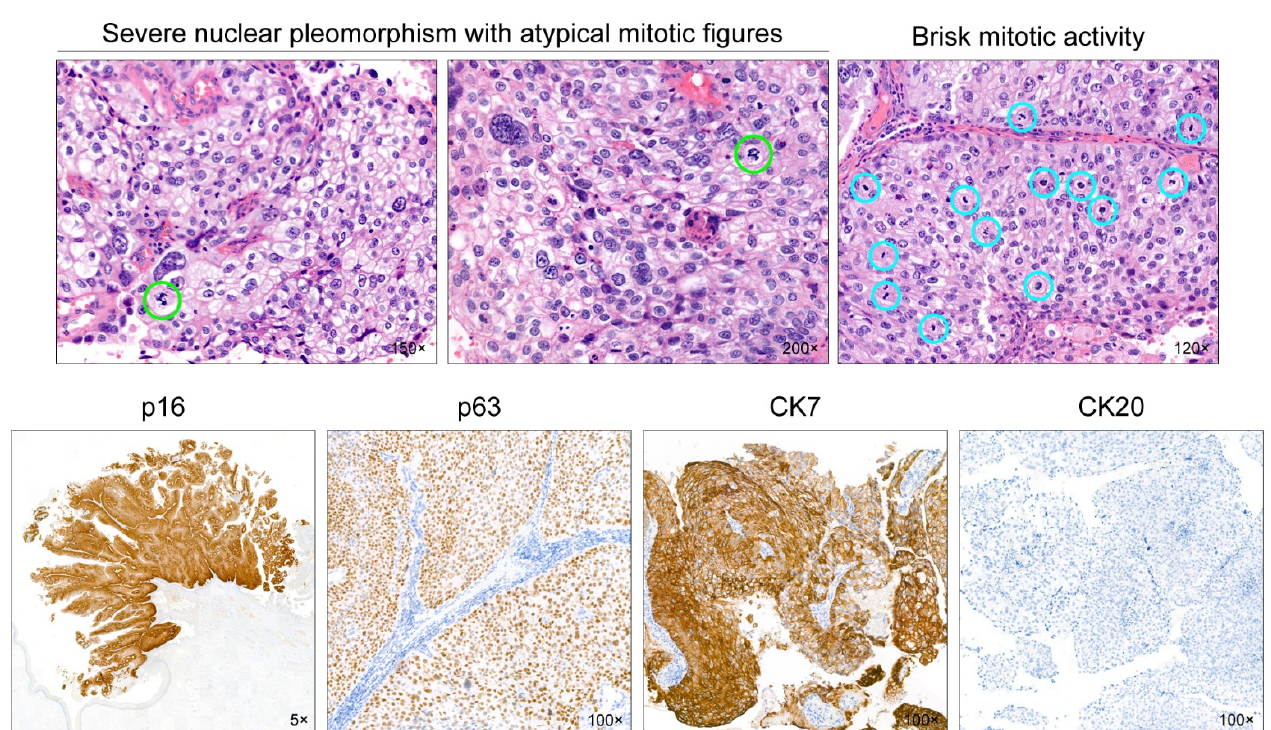
Figure 3. Microscopic findings and immunostaining results. A few microscopic foci (yellow arrow- heads) of superficial stromal invasion are noted. The invasion depth measures 1 mm at the deepest point. The tumor cells demonstrate moderate-to-severe nuclear pleomorphism accompanied by oc- casional atypical mitotic figures (green circles). Mitotic activity is brisk (blue circles). Immunohisto- chemically, the tumor exhibits block p16 positivity and diffuse and strong p63 expression, support- ing the diagnosis of human papillomavirus-associated squamous cell carcinoma. Cytokeratin 7 (CK7) is uniformly and intensely positive for the tumor cells, whereas CK20 is completely negative, indicating this tumor is a variant of squamous cell carcinoma.